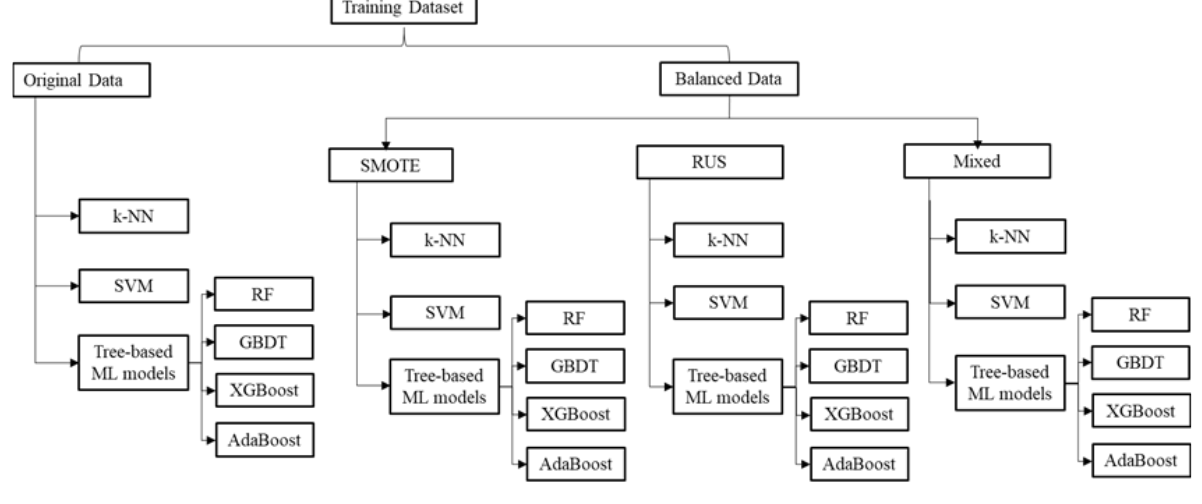
Figure 2. Study Scenarios.